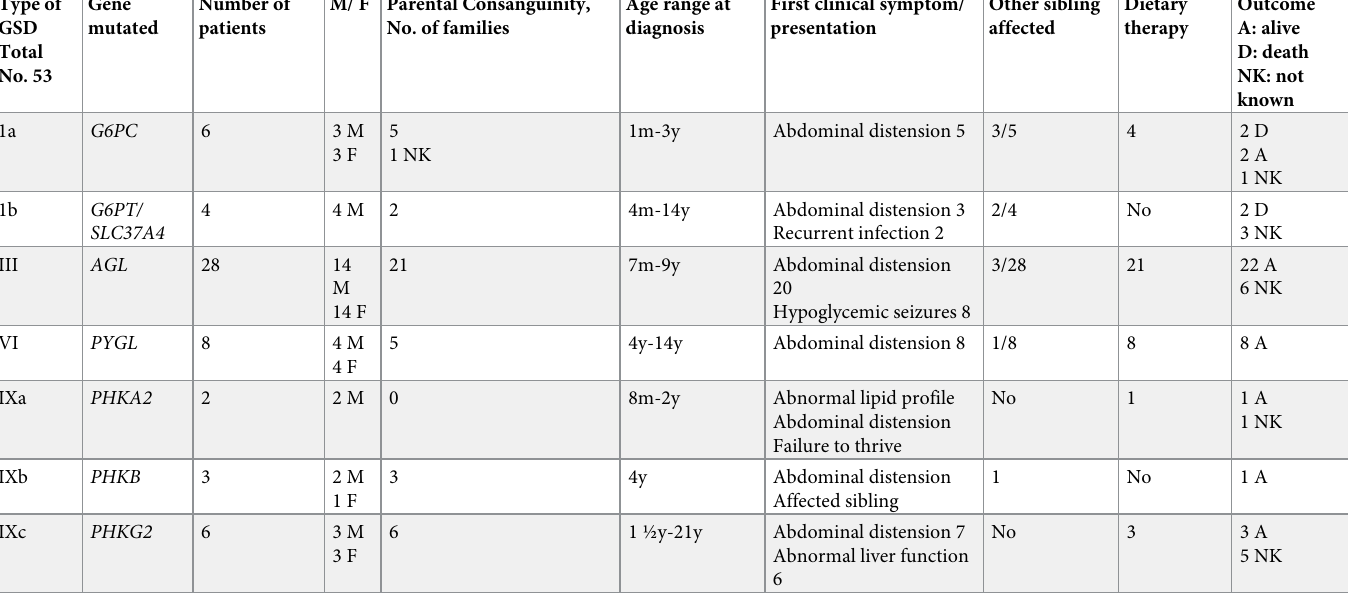
Table 2. Demographic details of 57 affected individuals with